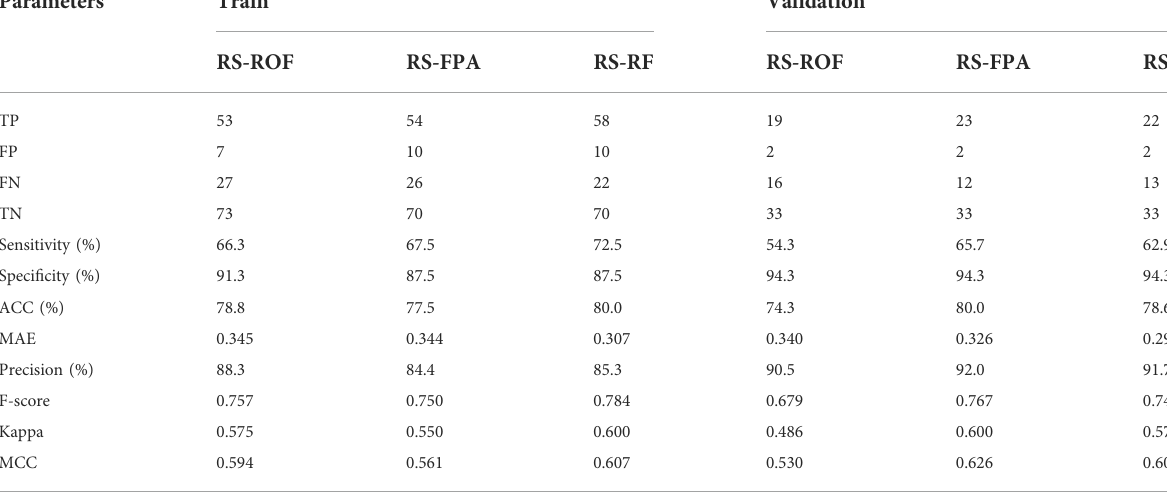
TABLE 4 The performance of the training set and the validation set of models using slope unit.